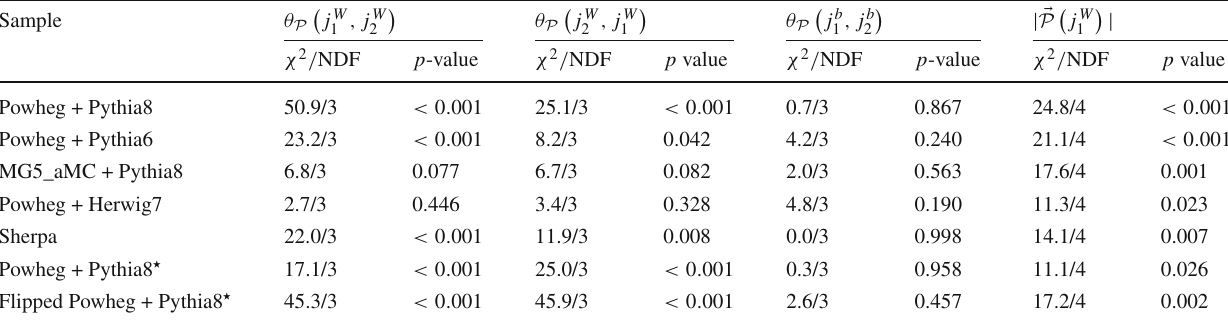
Table 5 The χ 2 and resulting p values for the measured normalised cross-sections obtained by comparing the different predictions to the unfolded data. When comparing the data with the prediction for the exotic flipped colour-flow model, the model itself is considered as an